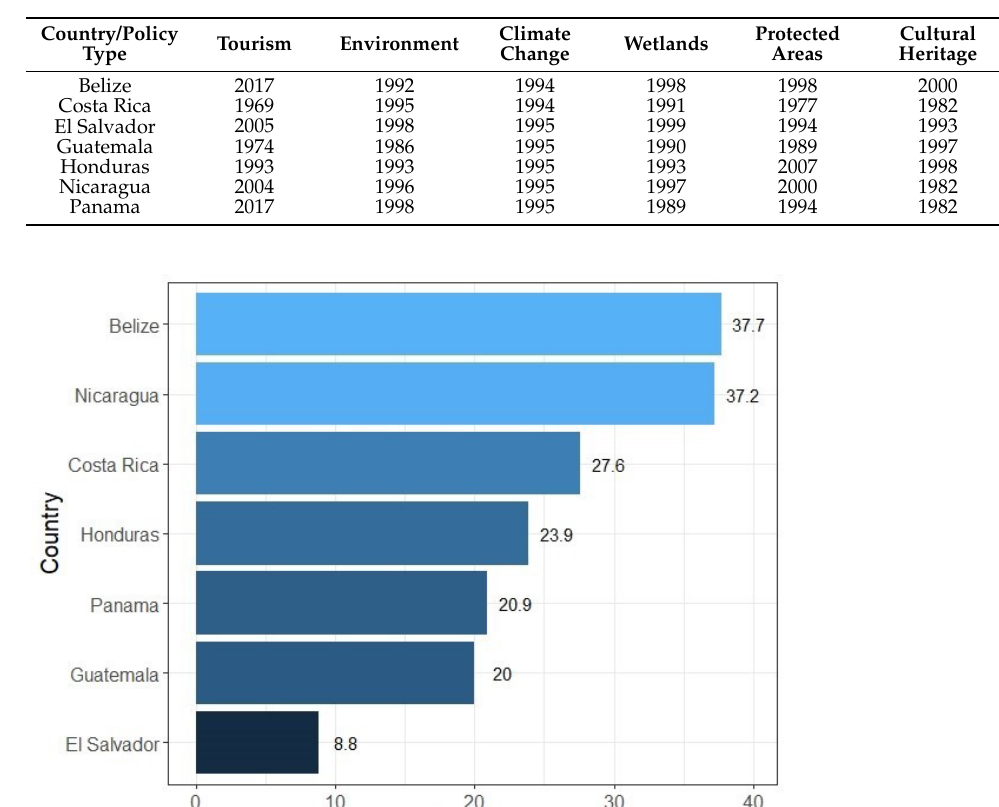
Table 2. Enactment year of the environmental, cultural heritage, and tourism policies in Central America.